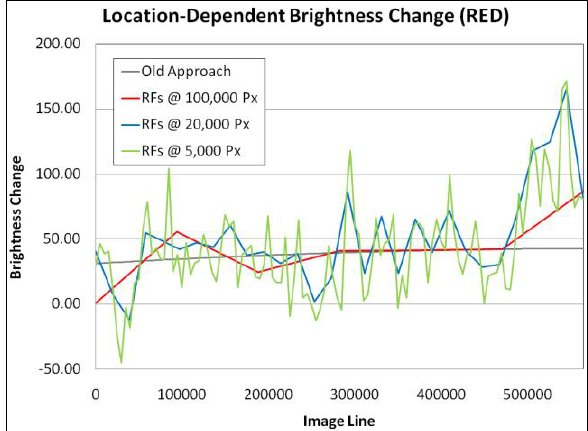
Figure 8. Brightness correction along an ADS strip (center of the overlap): ‘old’ polynomial model (Gehrke, 2010) vs. radio- metry fix model with different along-strip spacing of 100,000, 20,000 and 5,000 image pixels between radiometry